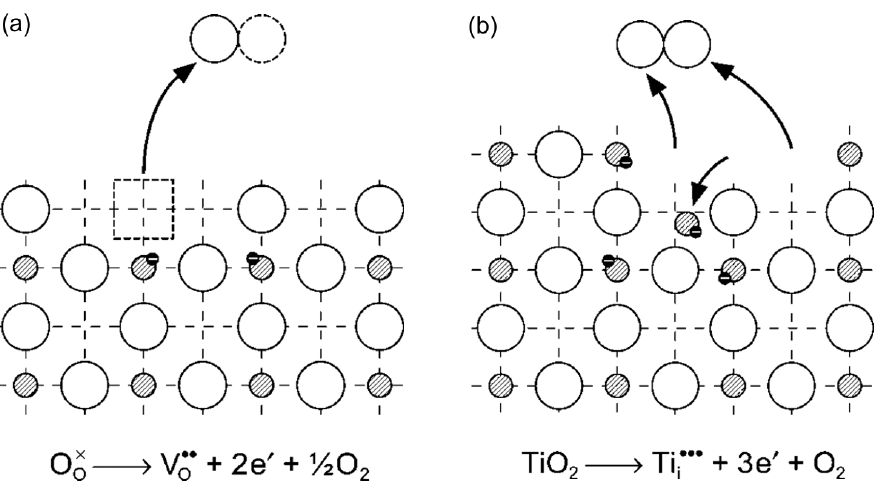
Figure 1. Formation of doubly ionized oxygen vacancy ( a ) and trivalent titanium interstitial ( b ): large and small circles represent lattice oxygen and titanium ions, respectively; black circles denote electrons and the square represents an empty lattice site. Reprinted with permission from [28].